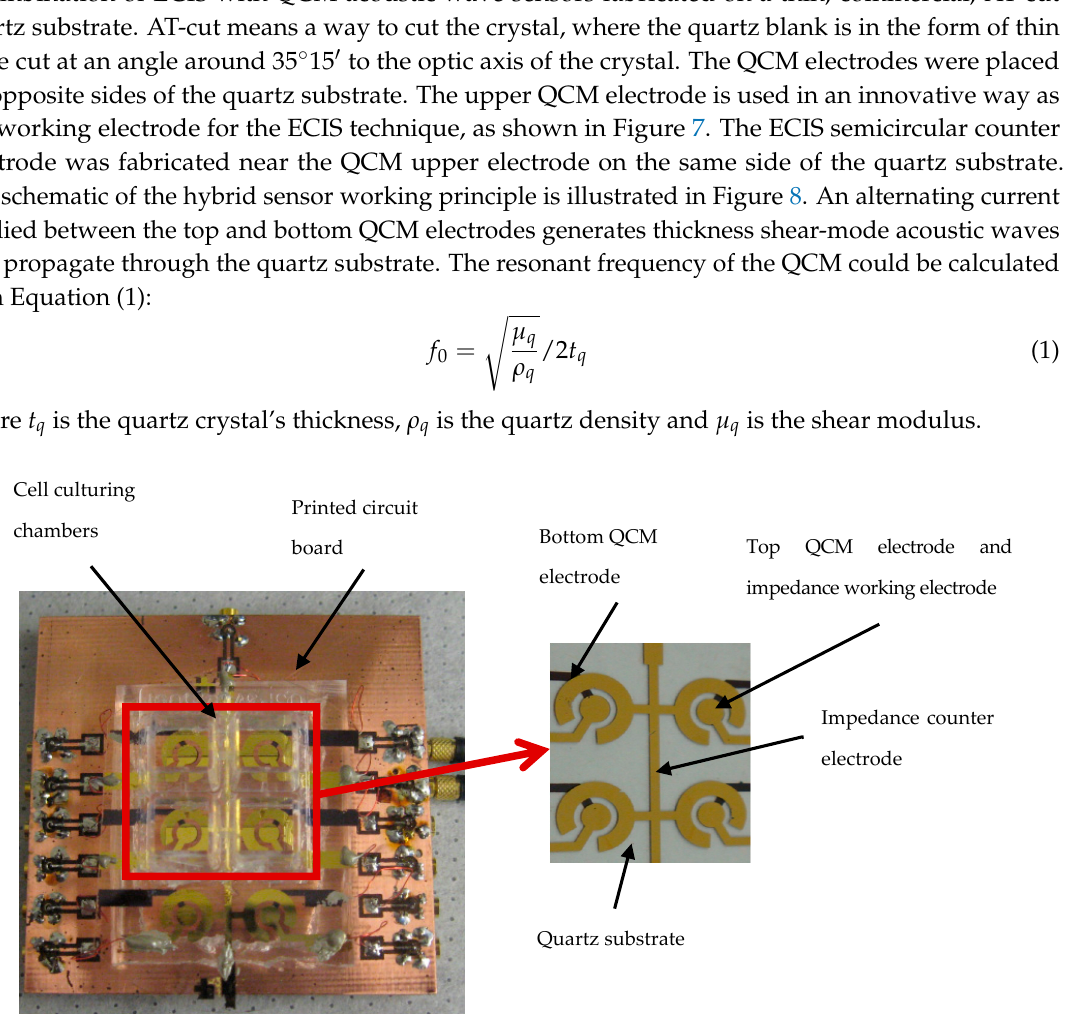
Figure 8. Illustration of the working principle of the hybrid biosensor which integrates the acoustic wave sensing with impedance spectroscopy technique [81]. The device presented in Figure 7 could simultaneously perform resonant frequency measurements and impedance measurements on the same cell monolayer cultured on the QCM